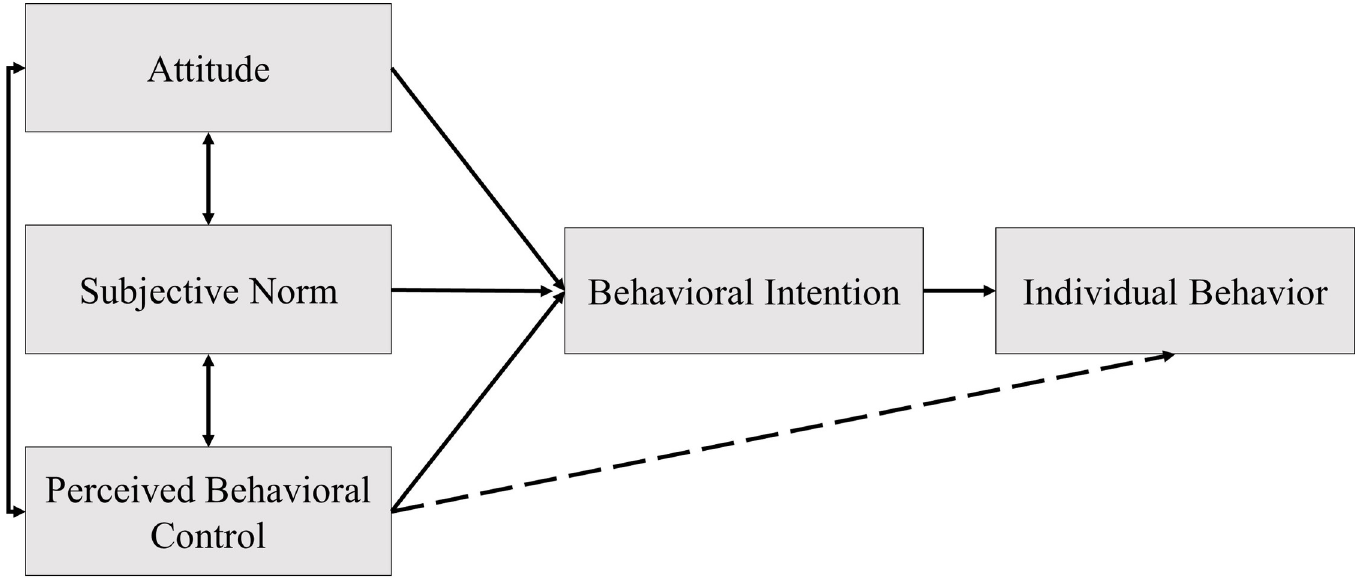
Fig 1. Theory of planned behavior model